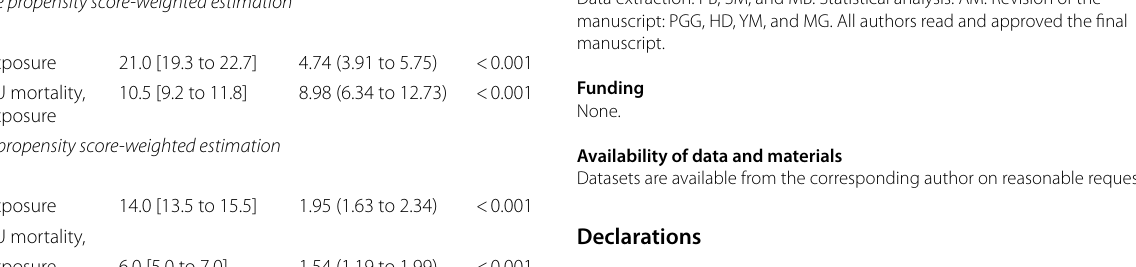
CI: confidence interval, OR: odds ratio, ICU: intensive care